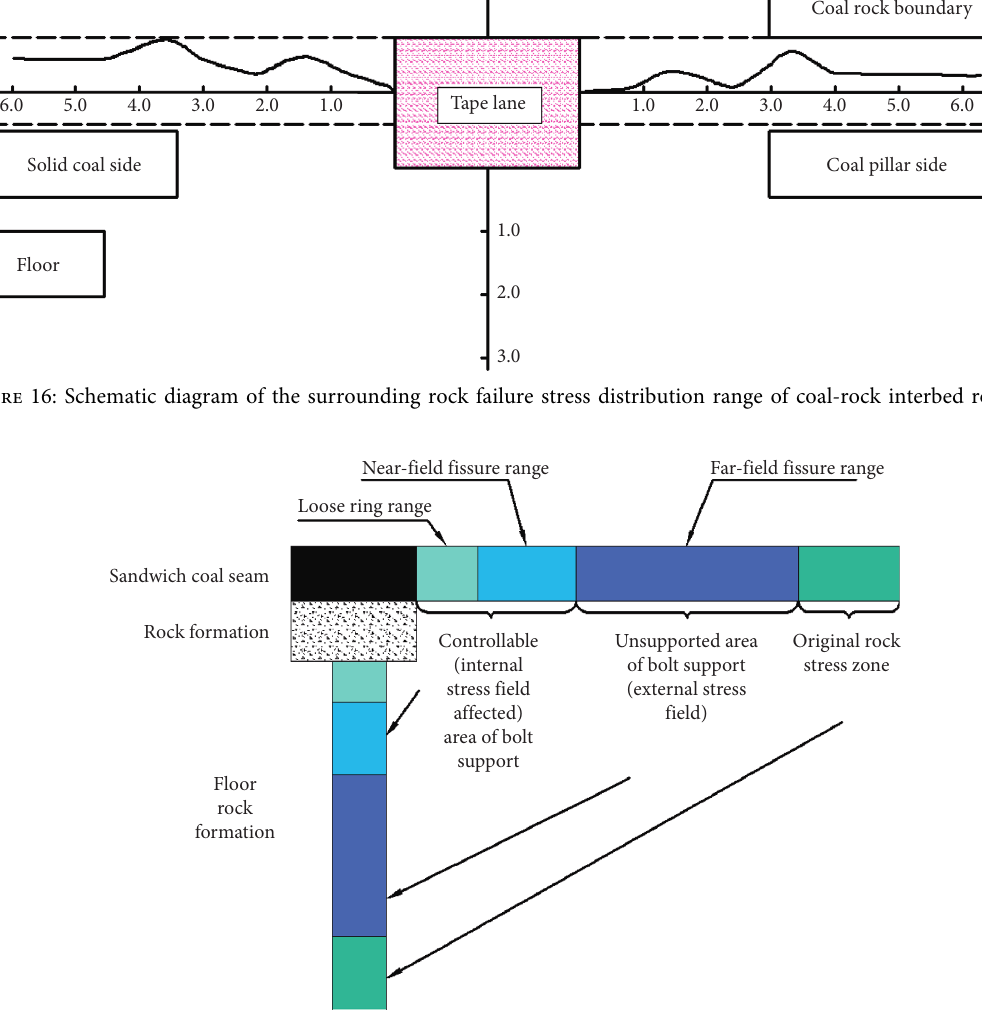
Figure 17: Schematic diagram of surrounding rock failure characteristics revealed by ultrasonic detection results.